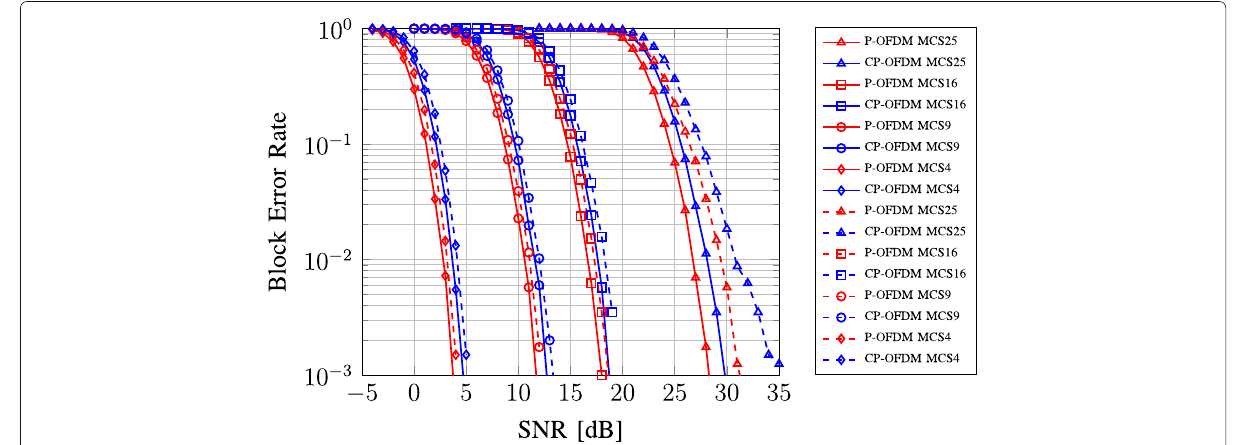
Fig. 22 Link level performance for high speed train (EVA channel, 500 km/h, 15 kHz subcarrier spacing)